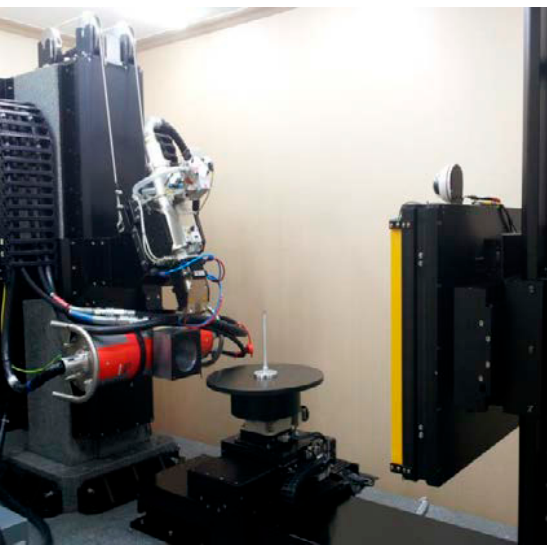
Figure 1. TheCT(ComputedTomography)equipmentwithahigh-powerX-raytube(450kV/max, Figure 1. The CT(Computed Tomography) equipment with a high-power X-ray tube (450 kV/max, 1500 W) .